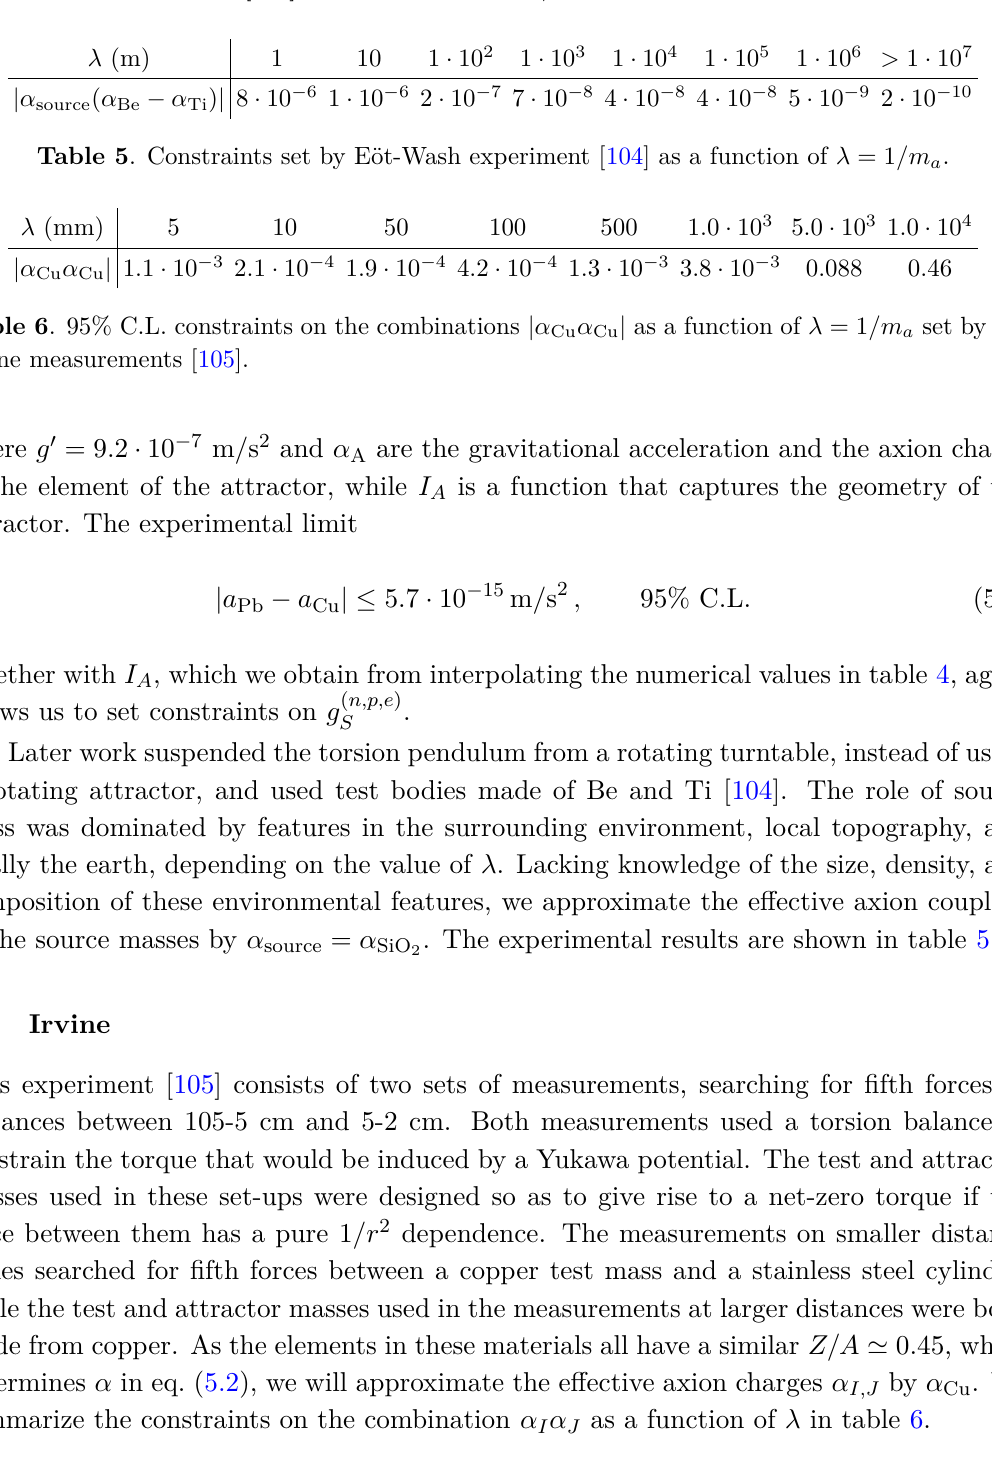
Table 4 . Numerical values for the function I A ( m a ) that describes the geometry of the attractor in the Eöt-Wash experiment [103] as a function of λ = 1 /m